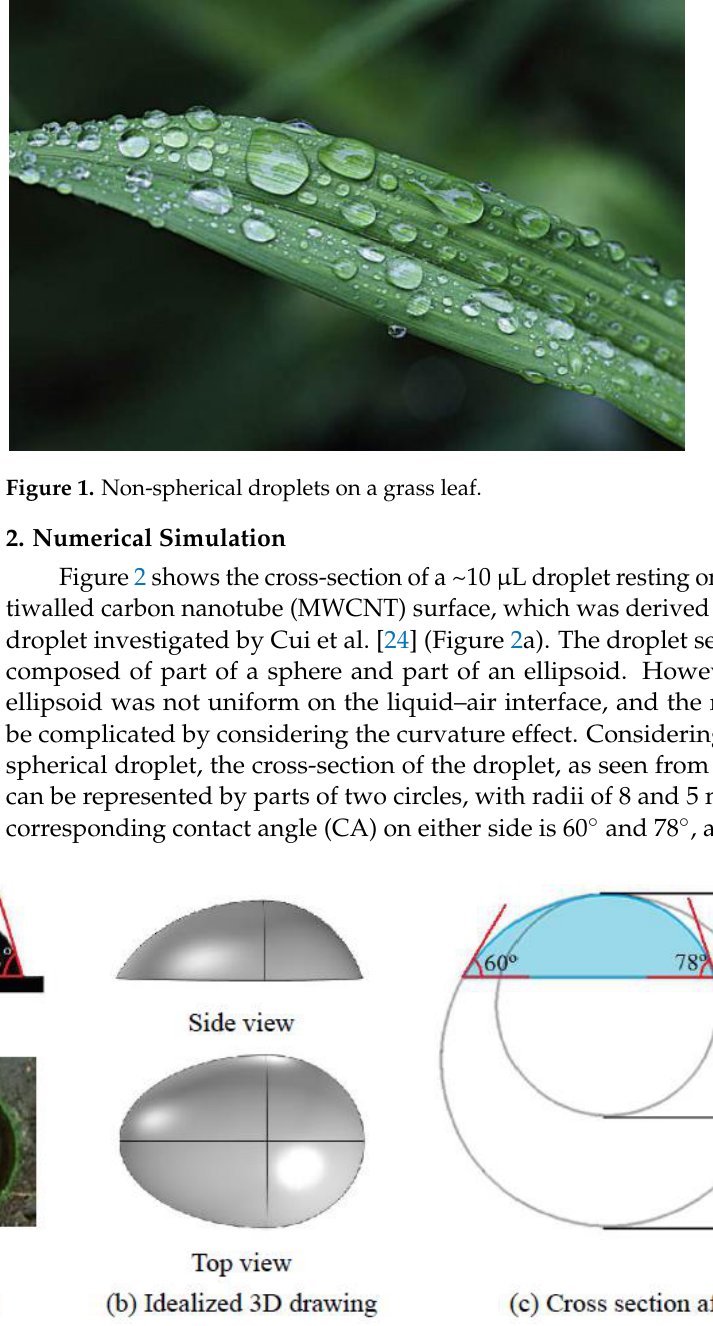
Figure 2. The cross-section of a non-spherical droplet derived from a real droplet. ( a ) is the top view and the side view of a real droplet resting on a hybrid structured MWCNT surface; ( b ) is an idealized 3D drawing of the real droplet ( a ) by composing part of a sphere and part of an ellipsoid; Based on ( b ), the non-spherical droplet cross section was further idealized by composing parts of two circles ( c ), which would be studied in this work.